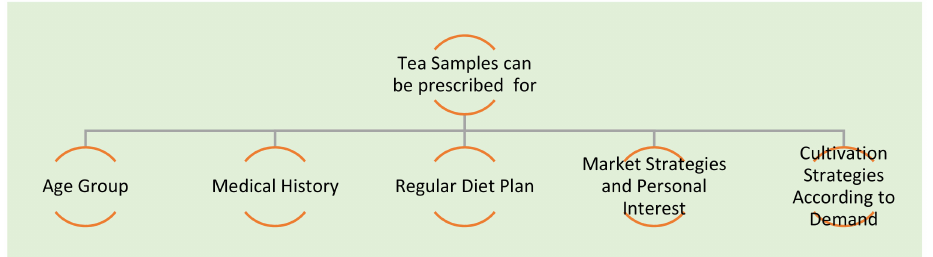
Figure 2. Tea prescription for various classes and their